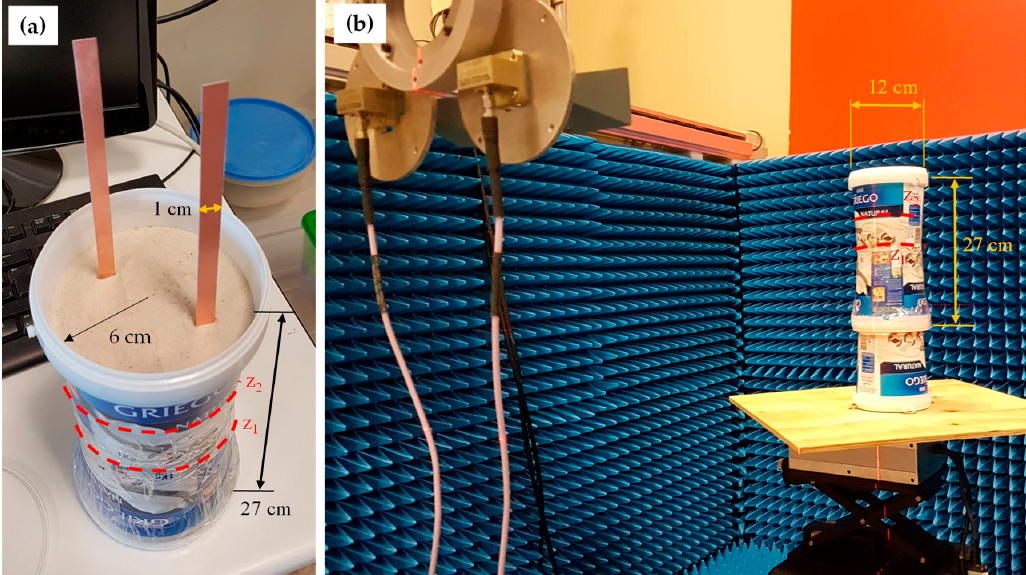
Figure 9. ( a ) Picture of the plastic box filled with sand, with two metallic plates embedded. ( b ) Picture of the OUT placed on the rotary platform.